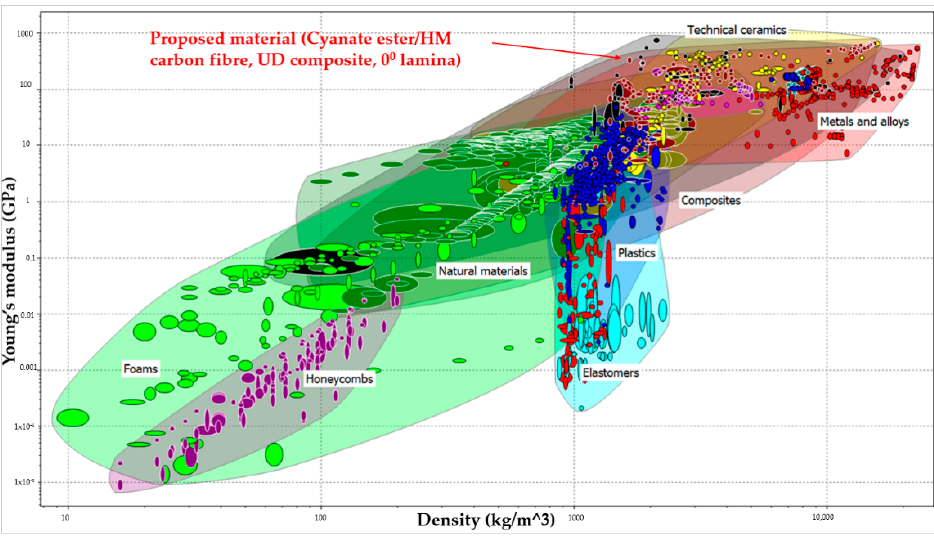
Figure 13. A comparison of the vertical stiffness of the meta-functional auxetic composite bridge bearing model, with different Young’s moduli and a common bridge bearing at the vertical displacement of 4 mm, between numerical and experimental relationships, respectively.